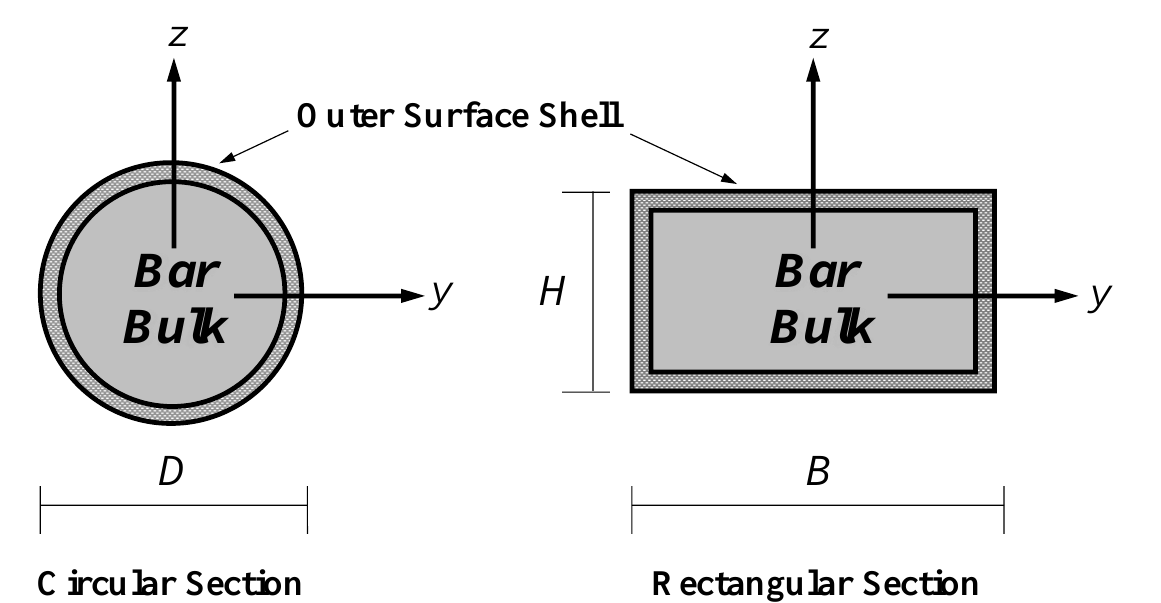
Figure 2. Composite nanobar cross-section: bar-bulk and outer wrapping surface shell.